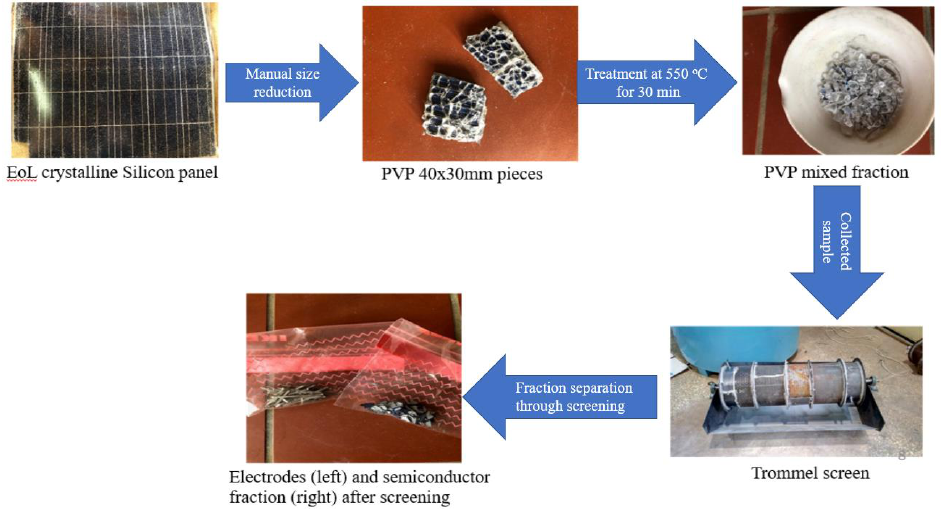
Figure 1. Material recovery process from first generation End-of-Life (EoL) photovoltaic panels